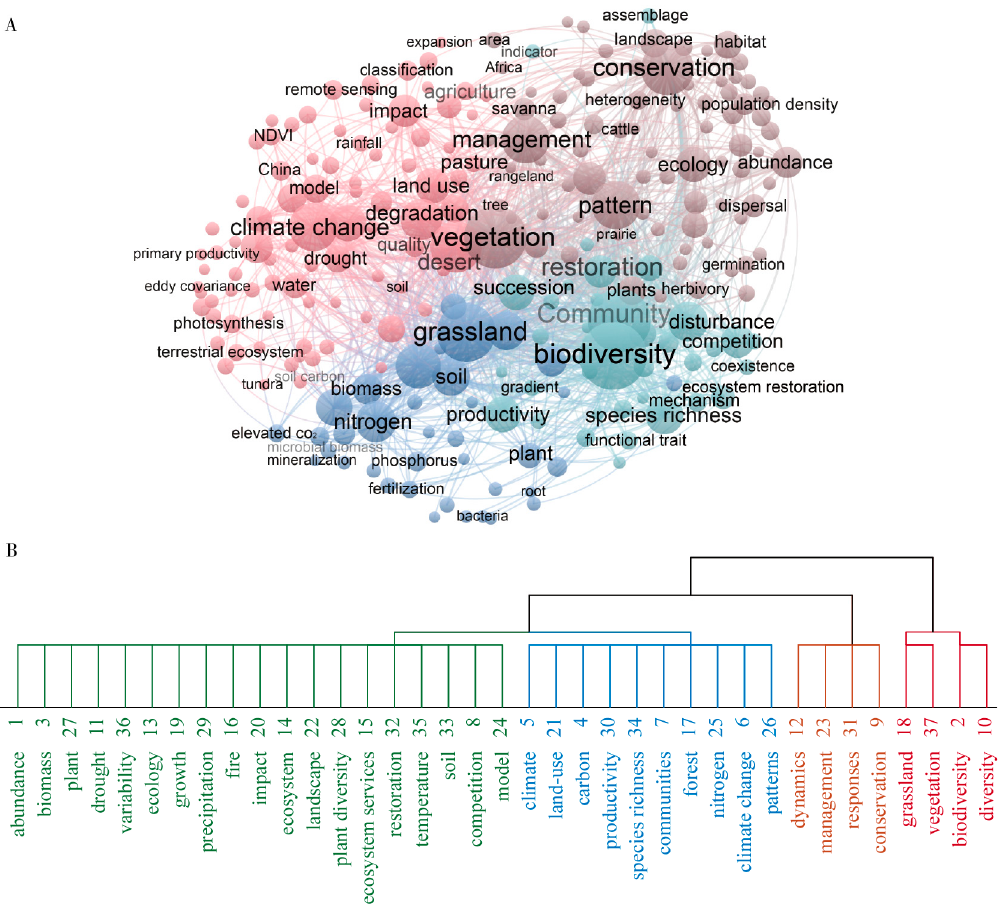
Figure 7. Keyword co-occurrence network ( A ) and cluster analysis ( B ) of grassland ecosystem (Every node in the network represented a keyword, size of nodes by occurrences, the link between the nodes means the keywords co-occurrence. Only keywords that met the threshold of a minimum number of occurrences > 170 were included in the study. Green and red part of the cluster indicated grassland ecological characteristics, blue part of the cluster indicated driving mechanisms, orange part of the cluster indicated grassland ecosystem services).